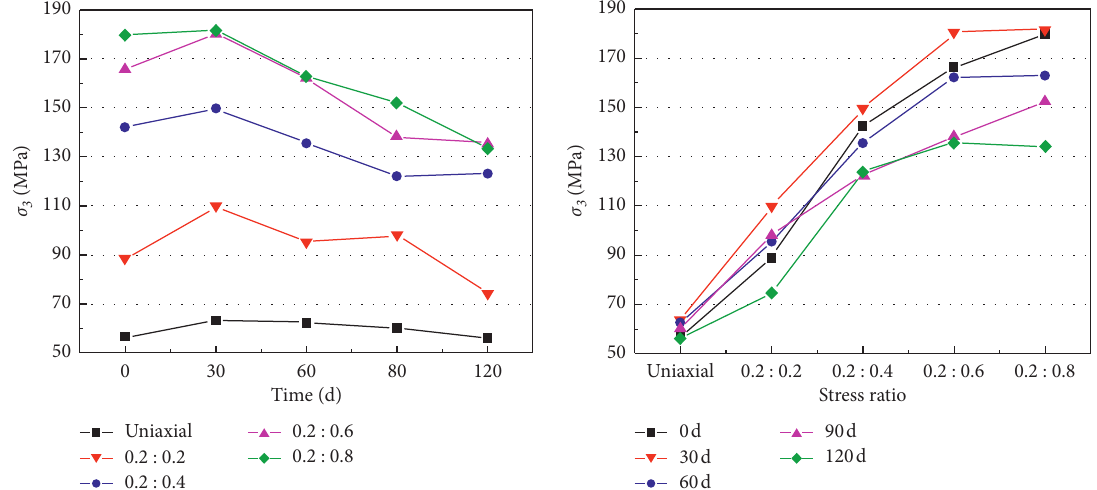
Figure 11: Variation of true triaxial compressive strength of concrete